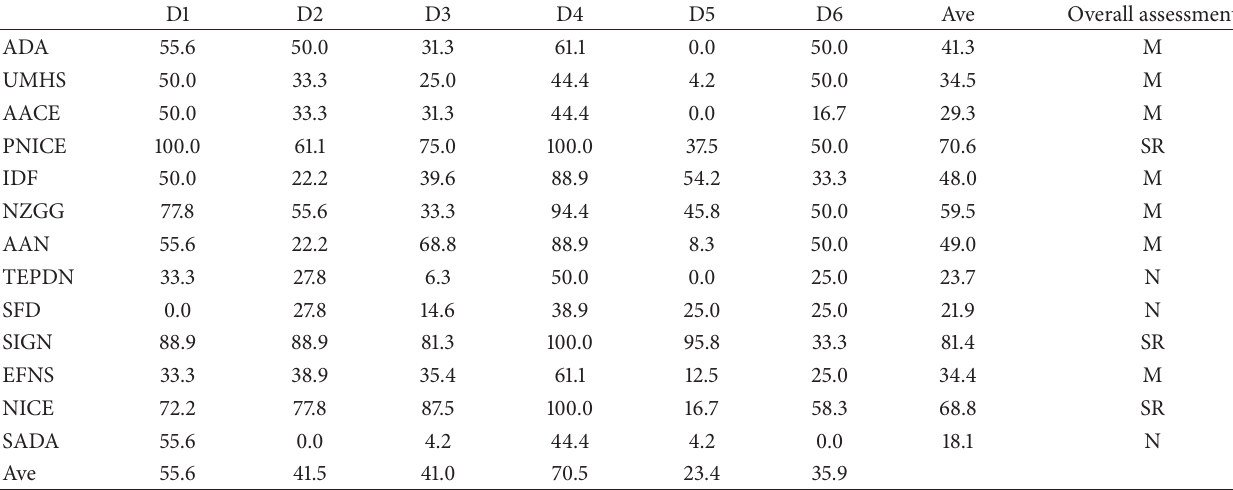
Table 7: Results of the assessment of the symptom management recommendations using the AGREE II instrument (domain scores in